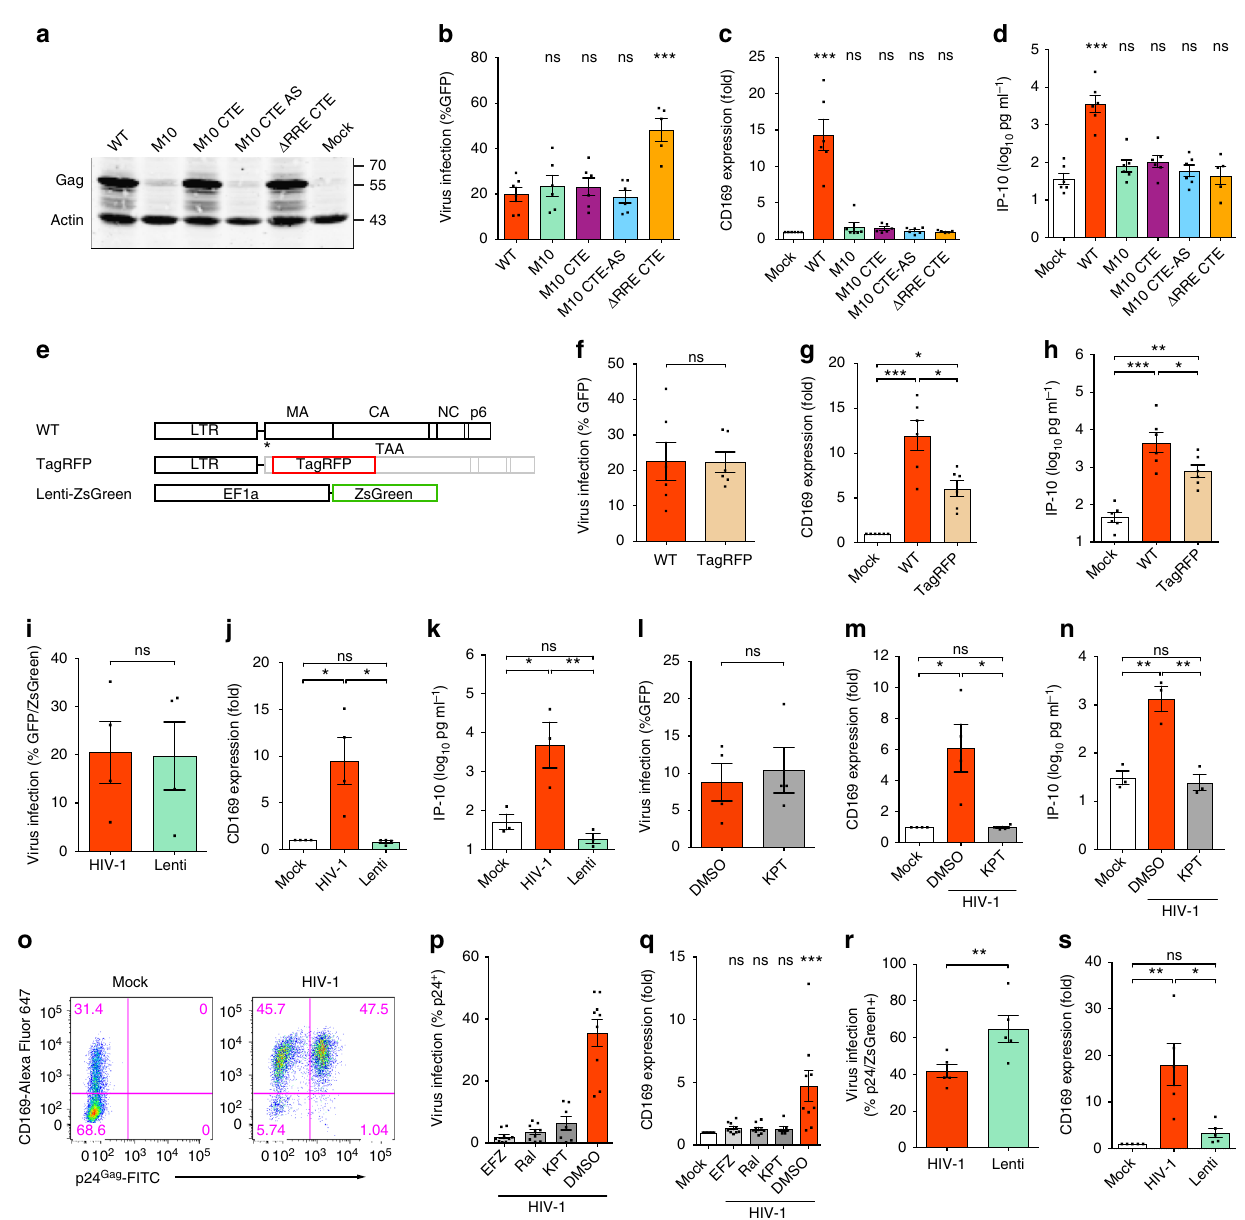
Fig. 3 Rev – CRM1-dependent HIV-1 icRNA export is required for sensing. a – d Effects of Rev/RRE mutations on Gag expression ( a ), GFP (multiply-spliced viral RNA) expression ( b ), CD169 expression ( c ), and IP-10 production ( d ) in MDMs 6 days post infection with HIV-1 (MOI of 2). e – n Schematic of TagRFP (Rev-dependent) expressing HIV-1 and ZsGreen (Rev-independent) expressing lentivector ( e ), GFP (viral) expression ( f , i ), CD169 expression ( g , j ), and IP-10 production ( h , k ) in MDMs 6 days post infection. l – n Effects of CRM1 inhibitor (KPT-330) on GFP (viral) expression ( l ), CD169 expression ( m ) and IP-10 production ( n ) in HIV-1 infected MDMs (MOI of 2). o Flow cytometry pro fi les (CD169 expression and intracellular p24 Gag ) of MDDCs infected with replication competent HIV-1 (MOI of 3), 3 days post infection. p , q Effects of HIV-1 inhibitors and CRM1 inhibitor on intracellular p24 Gag expression (viral infection) ( p ) and CD169 expression ( q ) in MDDCs. MDDCs were treated with drugs prior to infection (EFZ: efavirenz or Ral: raltegravir) or post infection (KPT-330) with replication competent HIV-1. r , s MDDCs were infected with replication competent HIV-1 (MOI of 0.1) or a lentivector expressing ZsGreen (Rev-independent, 100 ng p24 Gag ) in the presence of SIVmac Vpx and extent of infection (intracellular p24 Gag or ZsGreen) ( r ) and CD169 expression ( s ) were analyzed on day 3 post infection. The means ± SEM are shown and each symbol represents an independent experiment. Two-tailed p -values: one- way ANOVA followed by the Tukey-Kramer post-test ( g , h , j , k , m , n , and s ) or the Dunnett ’ s post-test ( b , c , d , and q ), or paired t -test ( f , i , l , and r ). * p < 0.05, ** p < 0.01, *** p < 0.001, ns: not signi fi